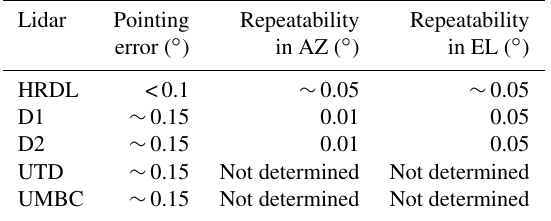
Table 2. Scanner pointing accuracy and repeatability estimates for the scanning Doppler lidars.